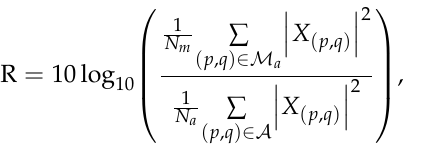
Figure 7. Azimuth ambiguity suppression via different algorithms. ( a ) Matched filtering. ( b ) Raw data-based sparse imaging method. ( c ) Complex image-based sparse imaging method.